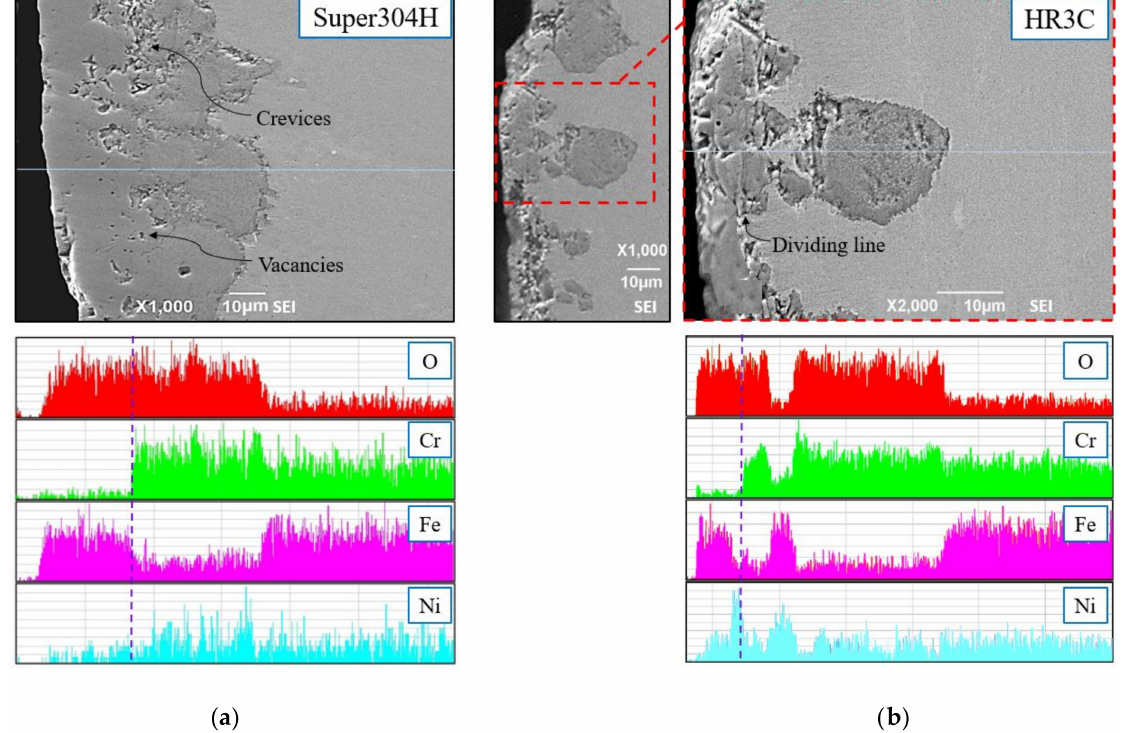
Figure 6. Cross-sectioned SEM image of: ( a ) Super304H, ( b ) HR3C steel oxidised for 17,973 h in a 1000 MW boiler under 26.15 MPa at 605 ◦